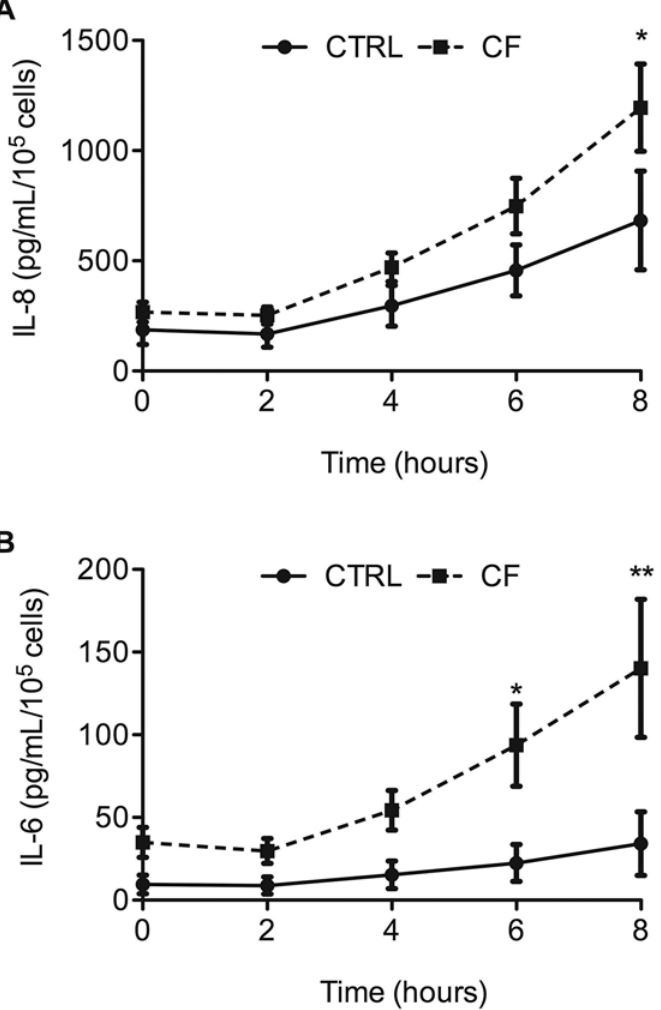
Fig 1. Validation of activation of primary bronchial epithelial cells (hAEBCs) upon P . aeruginosa infection. Kinetics of IL-8 (A) and IL-6 (B) production by hAEBCs infected with P . aeruginosa . At each time point, supernatants were collected for ELISAs of IL-8 and IL-6. The data are mean ± SEM of IL-8 or IL-6 concentrations for four different patients. The statistical analysis consisted in ANOVA followed by Bonferroni ’ s multiple comparison test. * P < 0.05 and ** P < 0.001. Each value in the cystic-fibrosis (CF) group was compared with the value at the same time point in the CTRL